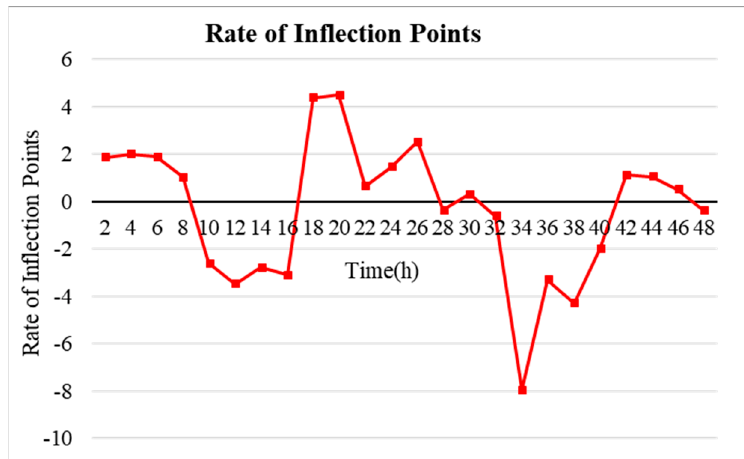
Figure 6. Rate of Inflection Points. Sensors 2020 , 20 , x FOR PEER REVIEW